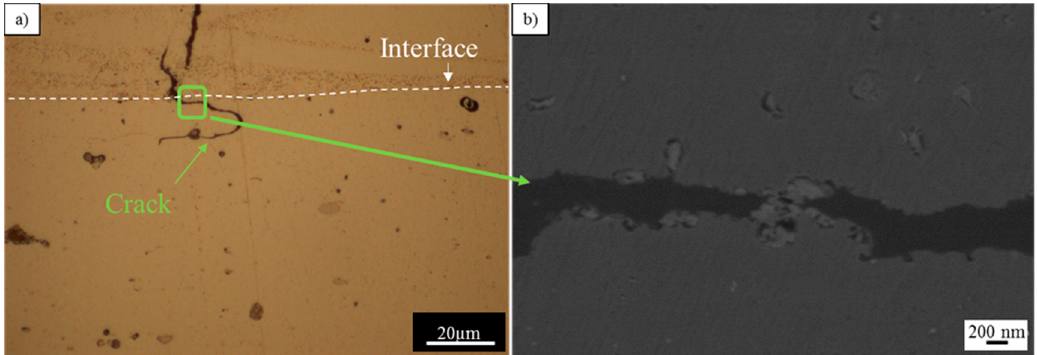
Figure 15. ( a ) OM micrograph of the deposit/substrate interface showing the crack that propagate in substrate along boundary grain, ( b ) higher magnification SEM image of liquation cracking.